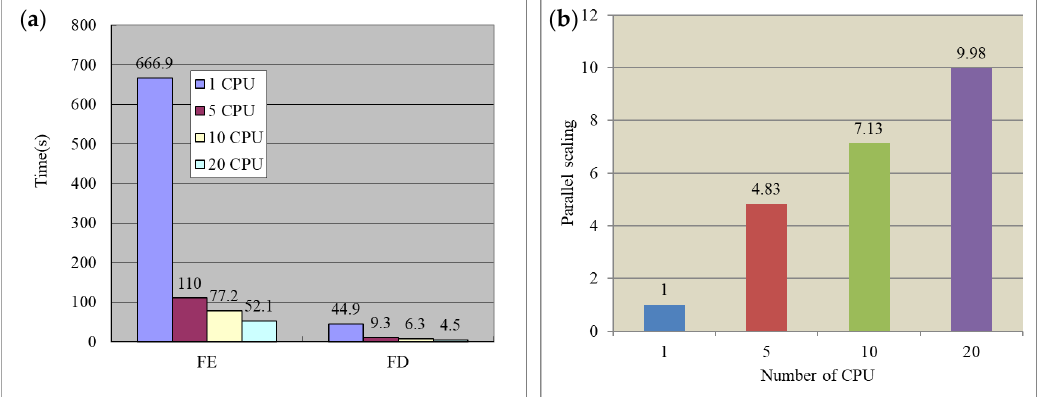
Figure 4. Comparisons of 2D forward-parallel-computing time ( a ) and parallel scaling ( b ) of different CPUs between FD and FE methods.